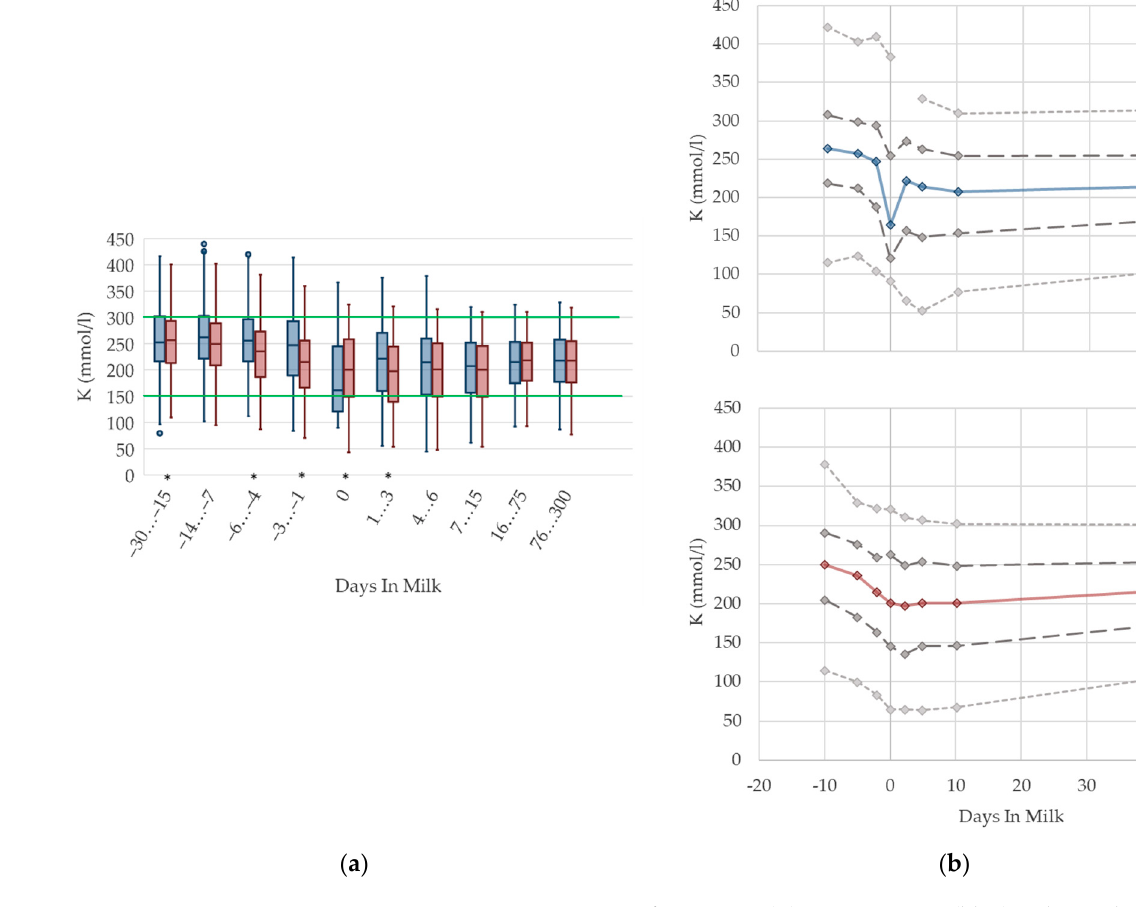
Figure 12. Urine concentrations of potassium (K) in primiparous (blue) and in multiparous (red) cows ( a ) in 10 classes between 30 days prepartum to 300 days postpartum (boxplots), green continuous lines represent the reference values according to Fürll [23], asterisk indicates significant differences regarding parity within DIM class; and ( b ) in 8 classes from 10 days prepartum to 40 days postpartum (median—continuous line; 1st and 3rd quartile—dashed lines; percentile 5 and 95—dotted lines).